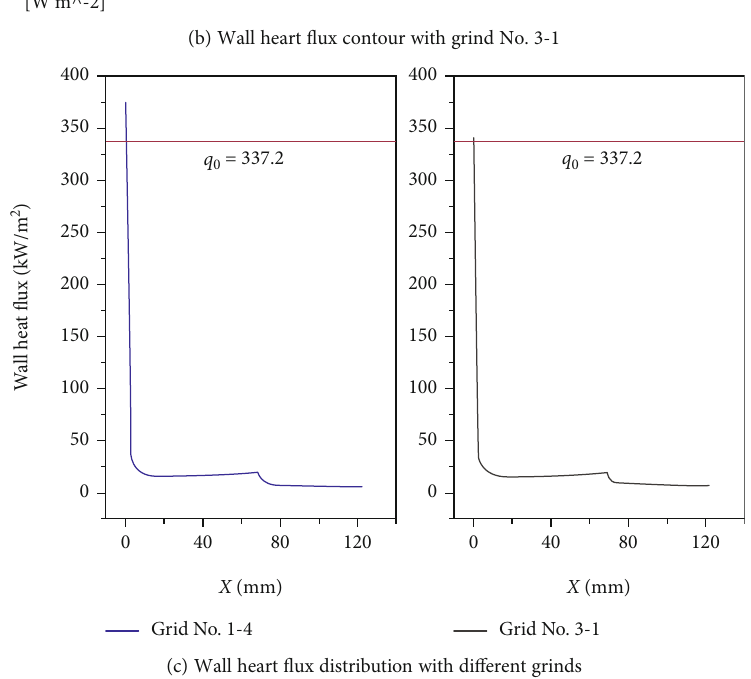
(c) Wall heart fl ux distribution with di ff erent grinds Figure 6: The wall heat fl ux contour at the wall surface with di ff erent